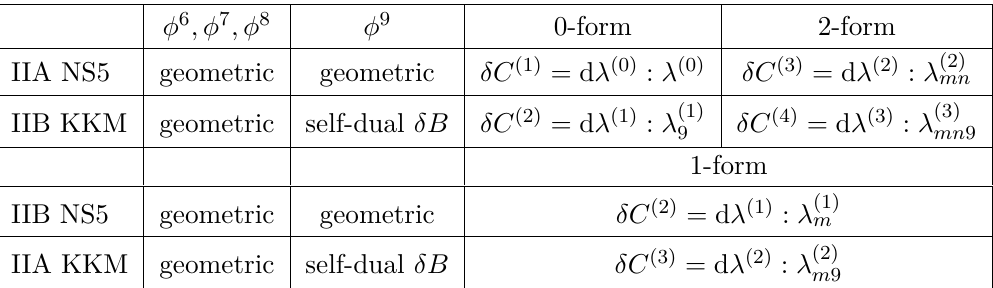
Table 2 . Physical interpretations of the zero-modes in the six-dimensional N = (2 , 0) tensor and the N = (1 , 1) vector multiplets. The cases of the NS5-brane and the KK-monopole. The index structures of the gauge parameters are specified